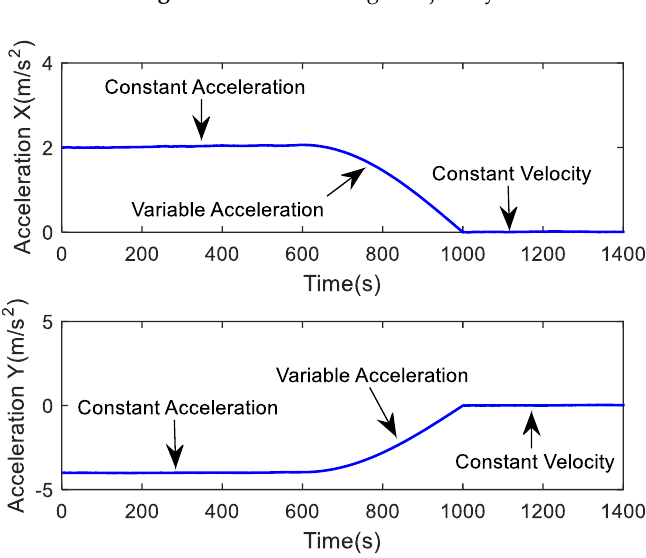
Figure 1. Simulated target trajectory.